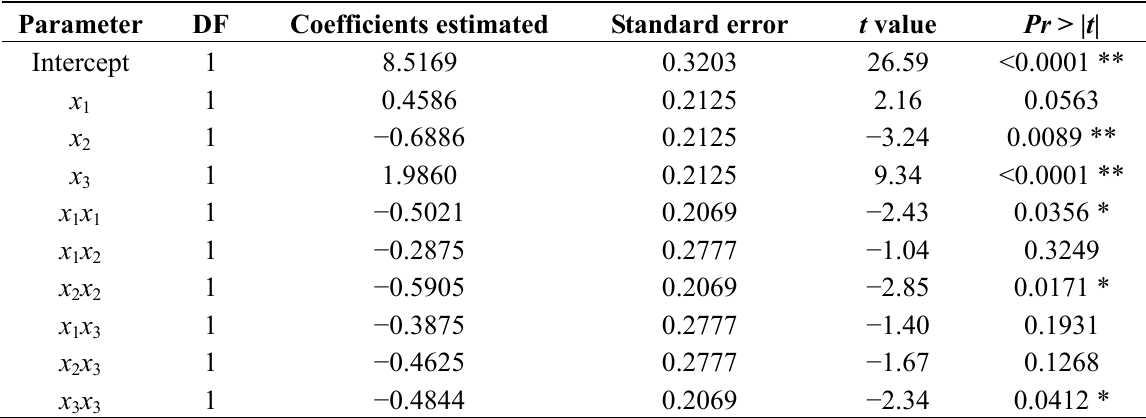
Table 5. Results of regression analysis of a predictive polynomial model for optimization of ganoderic acid Me (GA-Me) of G. lucidum